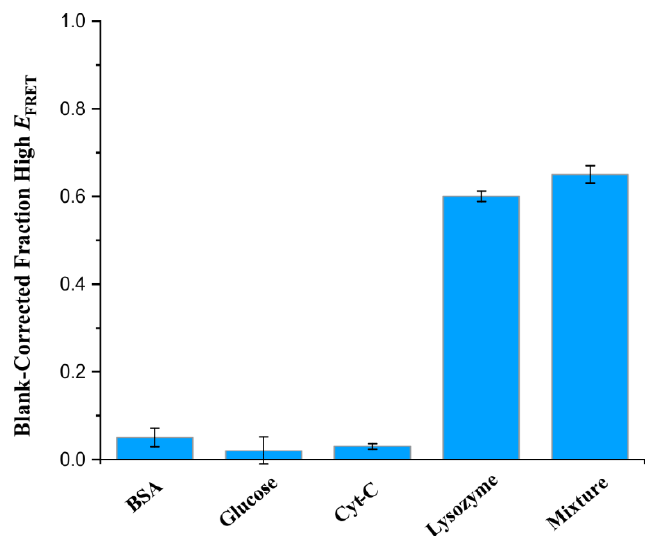
Figure 5. Selectivity test of the lysozyme aptasensor. The fraction of high- E FRET in the presence of potential binder / interfering agents at their biologically relevant concentrations. The specificity was tested against BSA (1 mM), glucose (5.5 mM), cytochrome C (Cyt-C, 150 nM), Lysozyme (2 µ M), and in a mixture of all targets (“Mixture”) at those concentrations. The fraction of the high- E FRET population for each of the conditions was determined from two-peak Gaussian fitting of the smFRET histograms and corrected for the blank. Error bars indicate standard deviation determined from three groups of molecules.